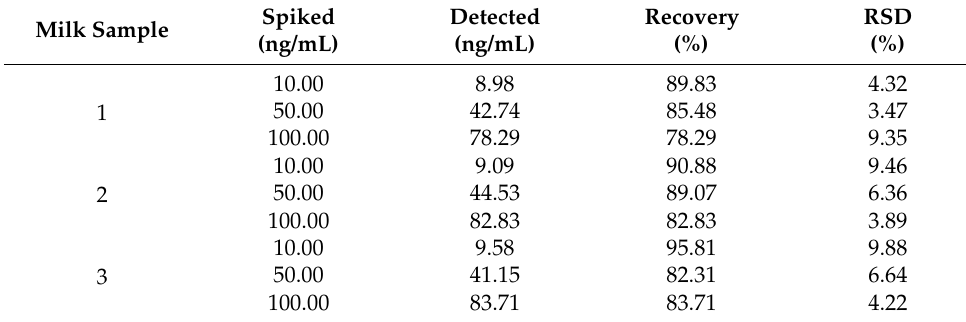
Table 2. Recovery rate experiment results for milk spiked with NOR ( n = 3).